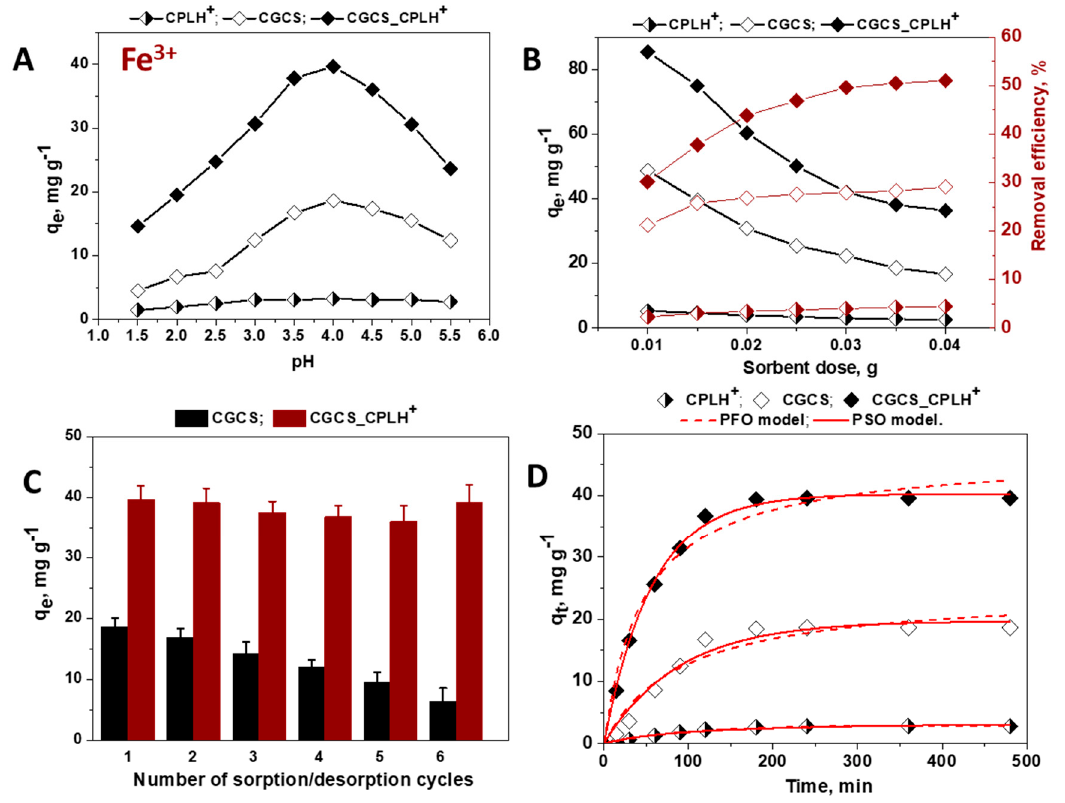
Figure 4. Influence of pH values ( A ), sorbent dose ( B ), successive sorption / desorption cycles ( C ), and contact time ( D ) onto Fe 3 + ions removal from multicomponent mixtures by CPLH + , CGCS, and CGCS_CPLH + sorbents.